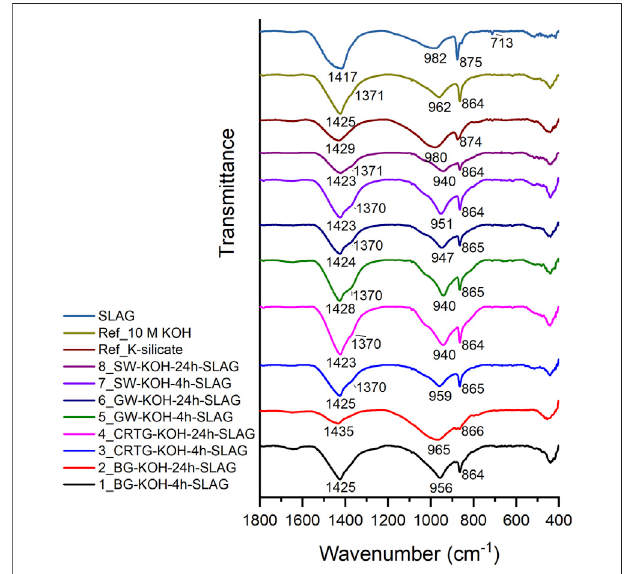
FIGURE 7 | FTIR spectra of the hardened binders composed of alkali- activated slag after curing for 72 h at 70 °